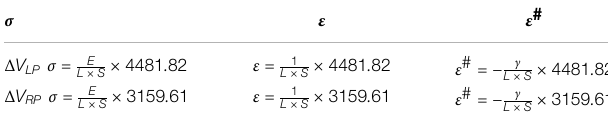
TABLE 3 | Relationship between stress strain and volume in theoretical